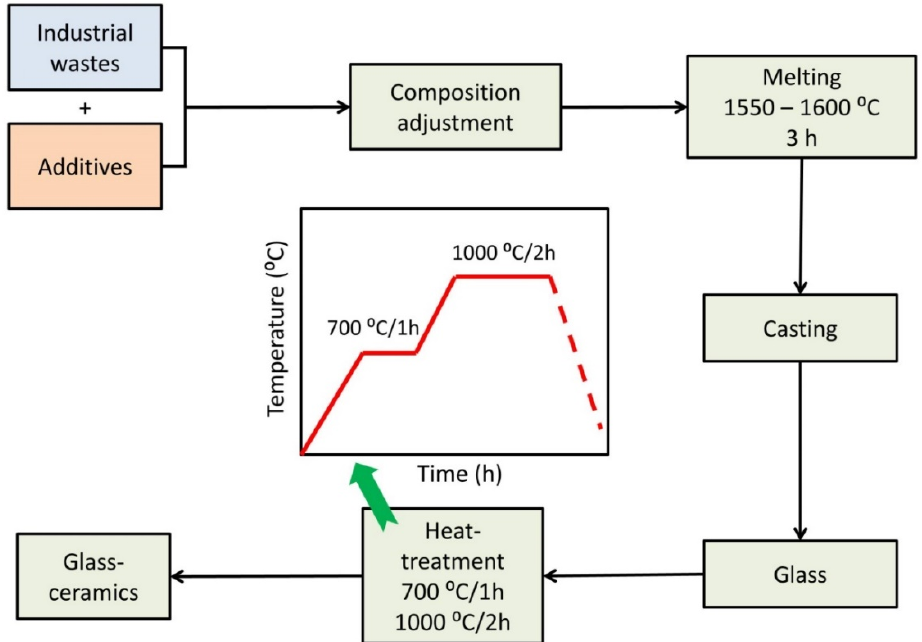
Figure 1. Schematic presentation for the production of glass and glass–ceramic materials from industrial